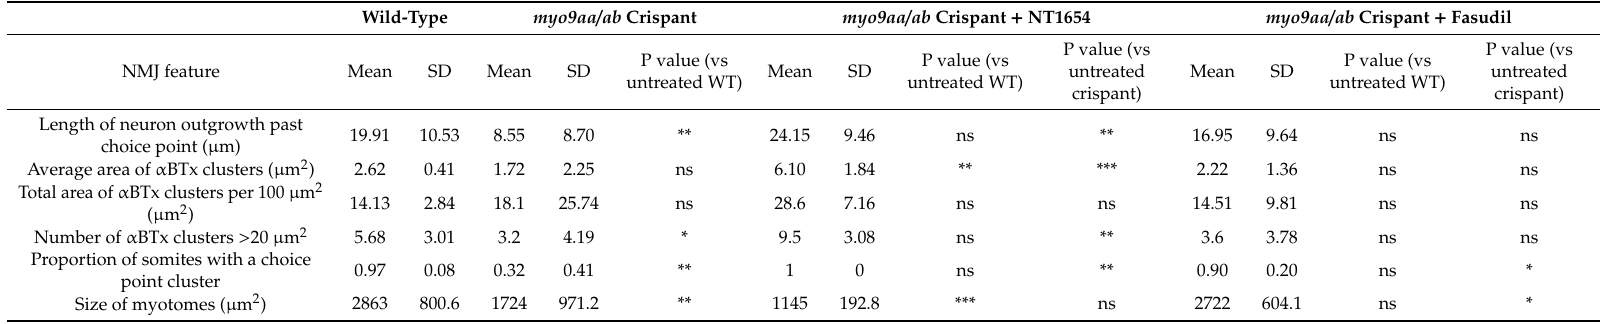
Table 1. NMJ morphology of myo9aa / ab crispant zebrafish at 24 hpf. A number of features of developing NMJs were characterised in wild-type ( n = 7 fish), myo9aa / ab crispant ( n = 6 fish), NT1654-treated (0.15ng, n = 7 fish) crispant, and fasudil-treated (10 µ m, n = 10 fish) crispant fish, encompassing both pre- and postsynaptic regions. The mean value, standard deviation (SD), and p -value are shown for each measurement, with treated fish compared to untreated crispants and wild-type zebrafish. Average area of α BTx and size of myotomes = One-way ANOVA. Number of clusters > 20 µ m 2 , length of neuron outgrowths past the choice point, and proportion of somites with a choice point cluster = Kruskal-Wallis